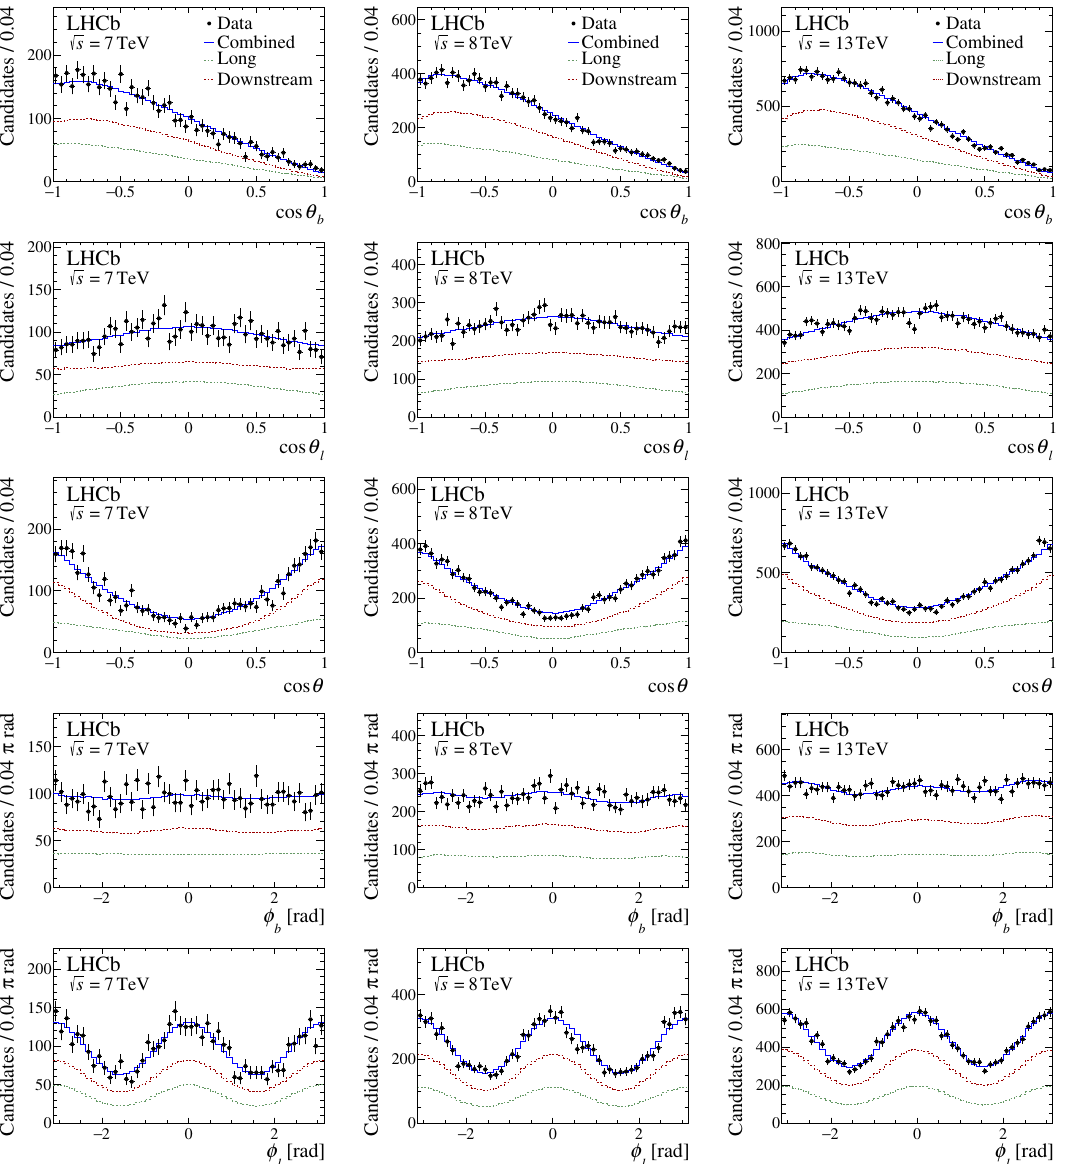
Figure 3 . Angular distributions of cos (cid:18) b , cos (cid:18) l , cos (cid:18) , (cid:30) b and (cid:30) l for the background-subtracted candidates. The long and downstream categories for the di(cid:11)erent data-taking years have been combined. The result of the moment analysis, folded with the angular e(cid:14)ciency, is overlaid. The contribution from the long and downstream categories are indicated by the green and red lines, respectively.